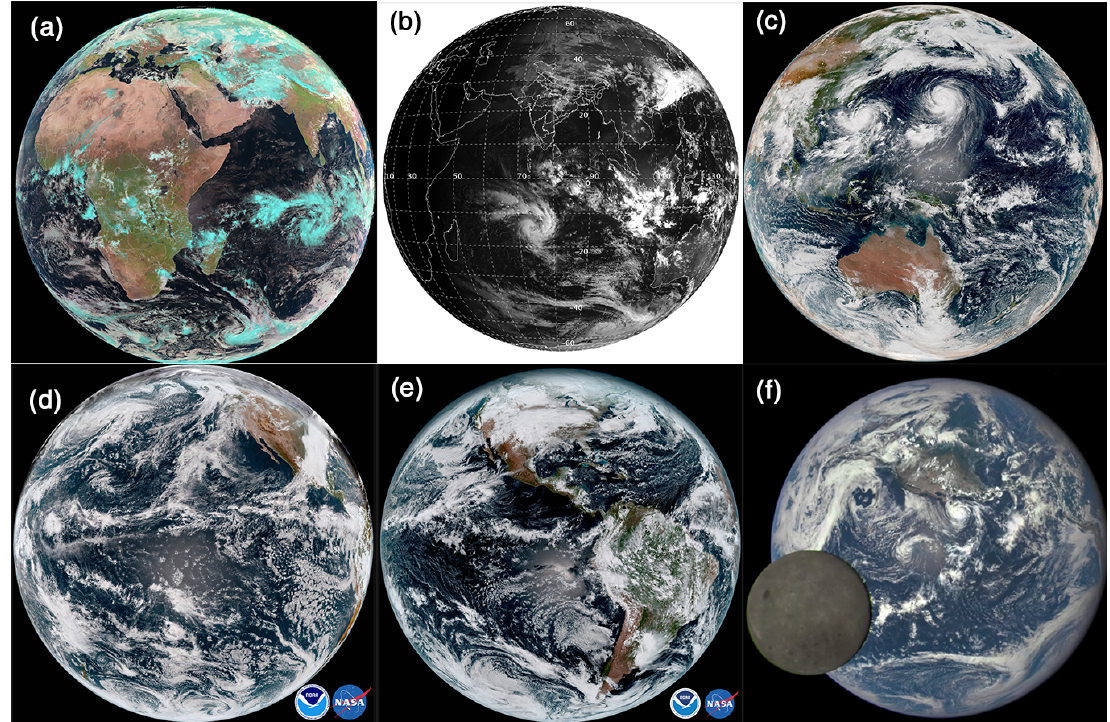
Figure 1. Earth observing geostationary satellite platforms. ( a ) MSG-3 at 0 ◦ longitude (true-colour image). ( b ) INSAT at 82 ◦ E longitude (single band visible). ( c ) Himawari-8 at 140 ◦ E longitude (true-colour image). ( d ) GOES-17 at 137.2 ◦ W longitude (true-colour image). ( e ) GOES-16 at 0 ◦ longitude (true-colour image). ( f ) EPIC/DSCOVR at the L1 lagrange point (true-colour) also showing the far side of the moon during a transit. Data courtesy of the meteorological agencies: Eumetsat (EU), NMSC (Government of India), JMA/JAXA (Japan), NASA and NOAA